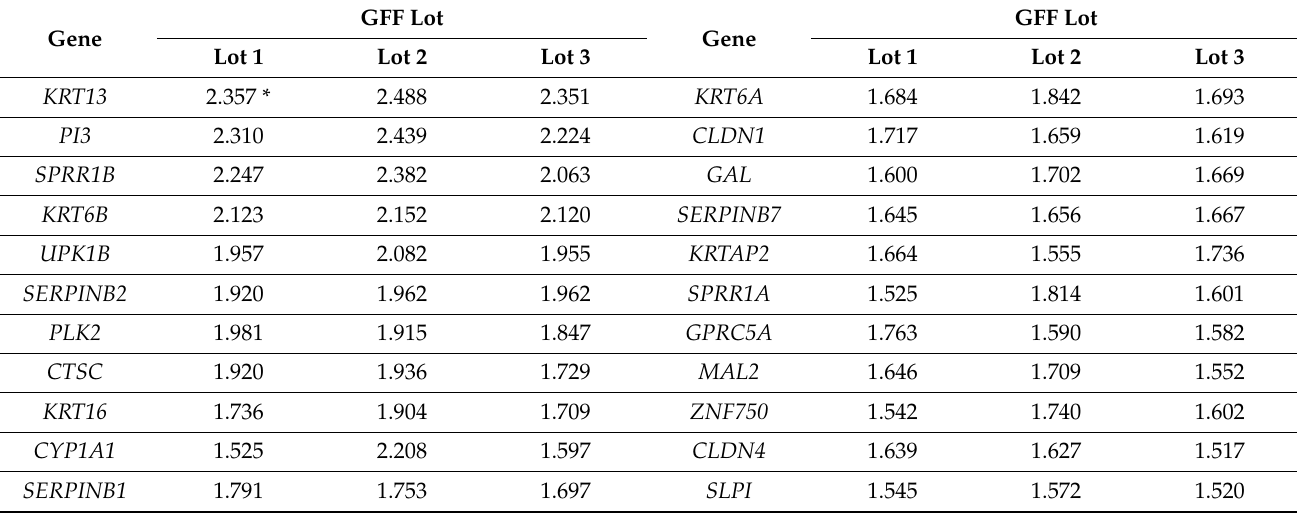
Table 1. Genes upregulated # by different lots of GFF.